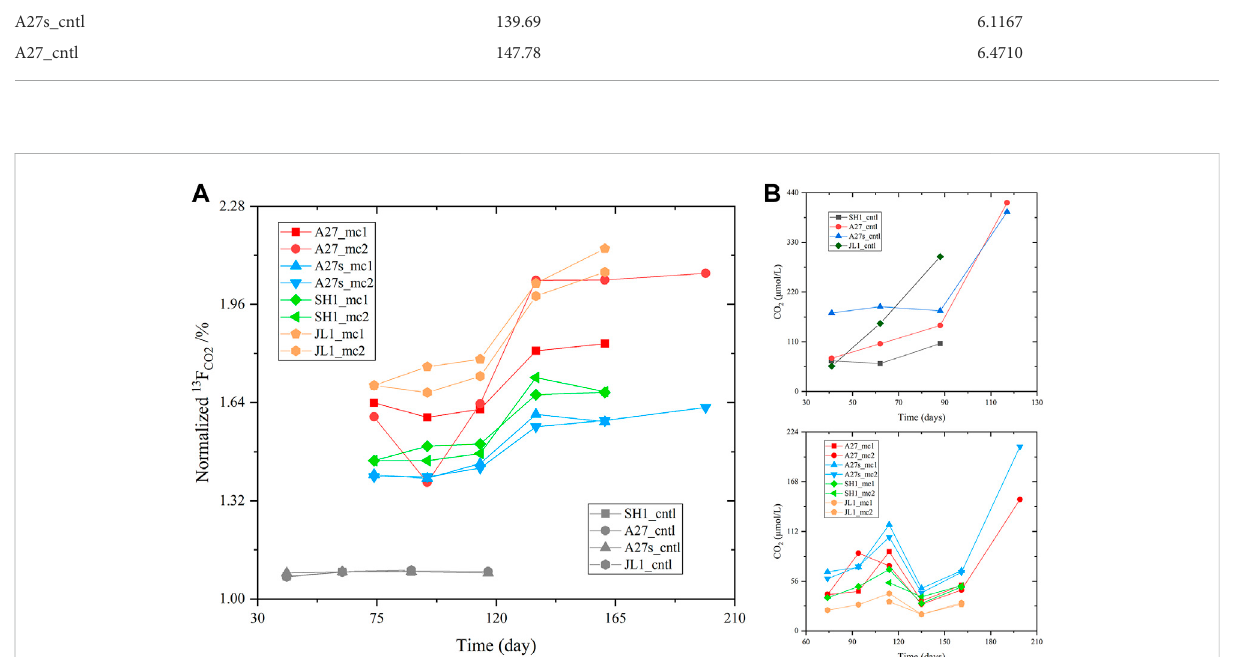
FIGURE 2 Time course of tested (A) normalized 13 F CO2 ( 13 CO 2 /( 12 CO 2 + 13 CO 2 ), which was calculated based on the δ 13 C-CO 2 measured during the incubation period) and (B) CO 2 concentrations in the headspace. The serial number of each incubation sample and its corresponding incubation conditions are listed in Table